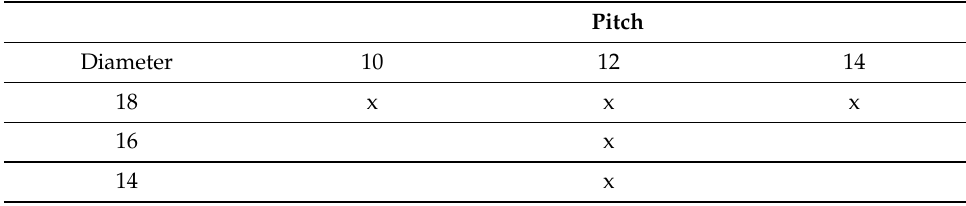
Table 3. Propeller test matrix to study effects of diameter and pitch.